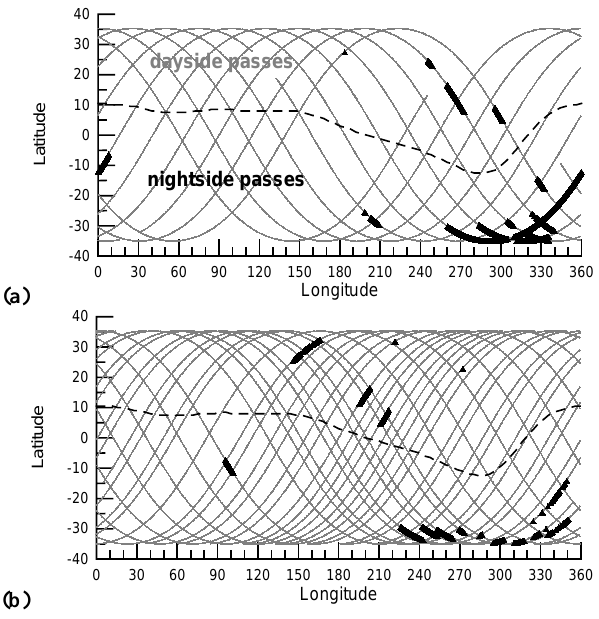
Fig. 6. Geographical location of most prominent ion density en- hancements (black triangles) observed by the ROCSAT-1/IPEI dur- ing (a) Bastille and (b) Halloween storms. The ROCSAT orbits are shown by gray dotted lines. The thick dashed line indicates the geomagnetic equator. The vast majority of the enhancements with rD > 10 is located in the South Atlantic region. During the Hal- loween event the ascending and descending parts of the ROCSAT-1 orbit correspond, respectively, to the nighttime and daytime passes.